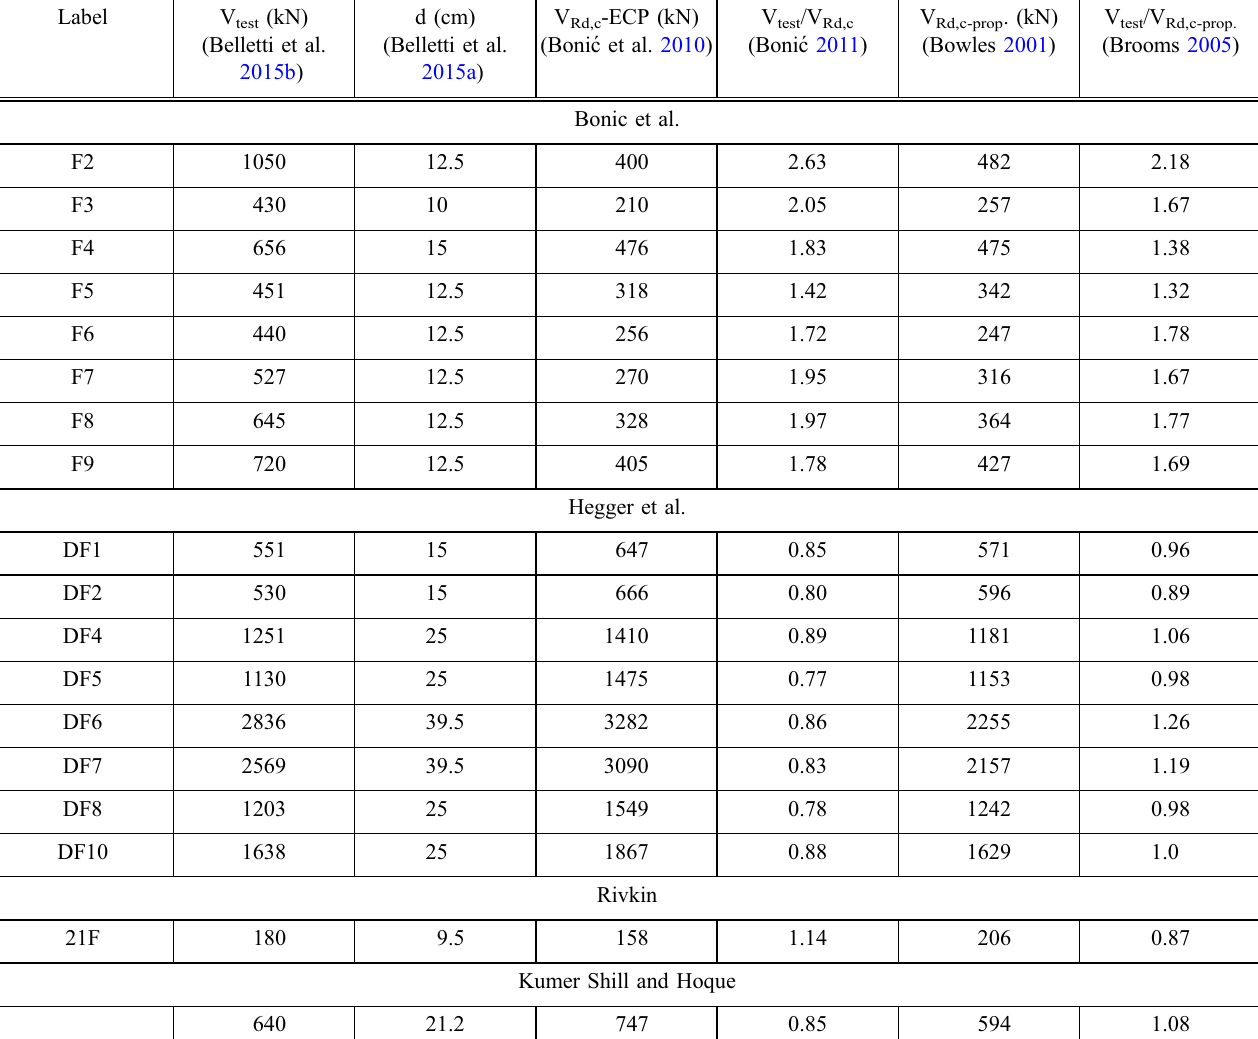
Table 6 Punching forces according to Eurocode 2 model and according to the proposed